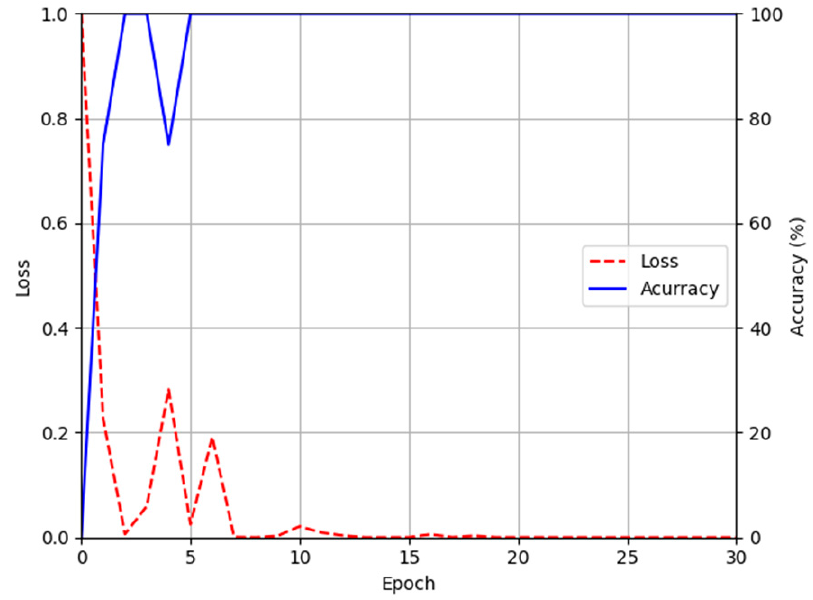
Figure 14. Training accuracy and loss graphs of DenseNet-161 using images restored by proposed modified DeblurGAN (PolyU-DB).